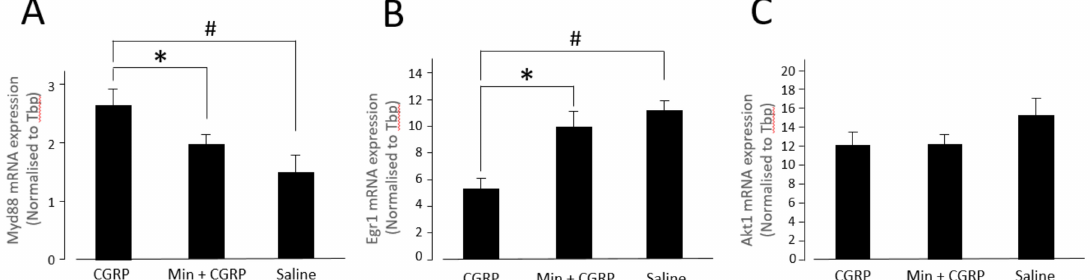
Figure 3. In array analysis CGRP stimulation of glial cells lead to an increased expression of Myd88 and Minocycline treatment before CGRP stimulation lead to an increased expression of Egr1 and Akt1 genes. Therefore, the e ff ect of intraganglionic (IG) CGRP and Min + CGRP on mRNA expression of Myd88 , Egr1 and Akt1 in Trigeminal ganglion after 6 h (In vivo) was analyzed. ( A ) An increase in mRNA expression of Myd88 was observed 6 h after CGRP injection compared to Saline injected control group. When Minocycline was injected 1 h before CGRP, decrease in the mRNA expression of Myd88 was observed compared to only CGRP injected group. ( B ) A decrease in mRNA expression of Egr1 was observed 6 h after CGRP injection compared to Saline injected control group. When Minocycline was injected 1 h before CGRP, an increase in the mRNA expression of Egr1 was observed compared to only CGRP injected group. ( C ) No statistical di ff erence was observed in between any group in the mRNA expression of Akt1 . # p < 0.05 with one-way ANOVA followed by the Dunnett t test for comparison with saline injection. * p < 0.05 with t test, n = 5 rats were assigned to each